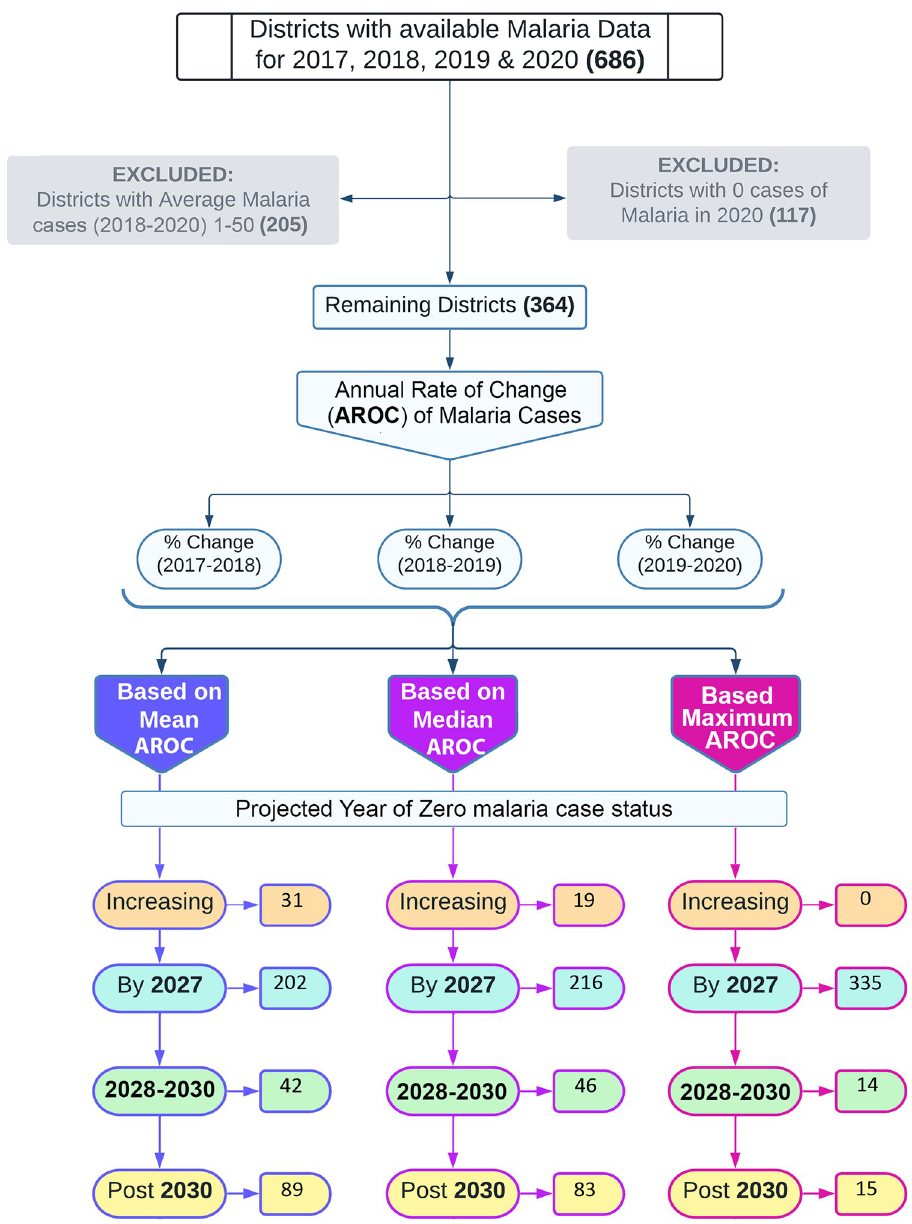
Fig 1. Flow chart representing the classification of districts based the projected year of achieving zero case status of malaria using on three methods: Mean AROC, median AROC and maximum AROC.